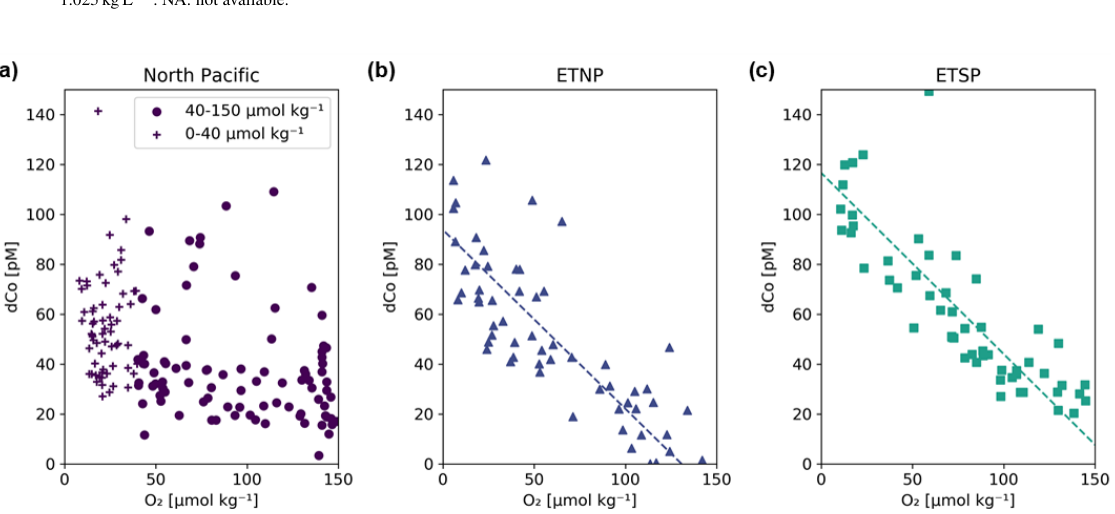
Figure 12. Dissolved dCo vs. O 2 relationships within the three Pacific OMZs. Data points from the North Pacific OMZ ( a ; Stations 3–18; − 1 display a wide range of dCo values, likely due to reminer- ≥ 500m depth) show a nonlinear trend where samples at O 2 < 40µmolkg alization and scavenging at shallow depths in the OMZ, and samples between 40–150µmolkg − 1 O 2 displayed little correlation. Samples from the ETNP ( b ; Stations 20–25; ≥ 200m depth) and ETSP ( c ; Stations 29–34; ≥ 200m depth) show a linear relationship between dCo and O 2 associated with advection from the eastern core of the OMZ. The ETNP displayed a dCo:O 2 slope of − 0.72 ± 0.07µM:molkg − 1 ( R 2 = 0.66, n = 58), and the ETSP displayed a dCo:O 2 slope of − 0.73 ± 0.06µM:molkg − 1 ( R 2 = 0.72, n = 54). See Appendix A for additional dCo:O 2